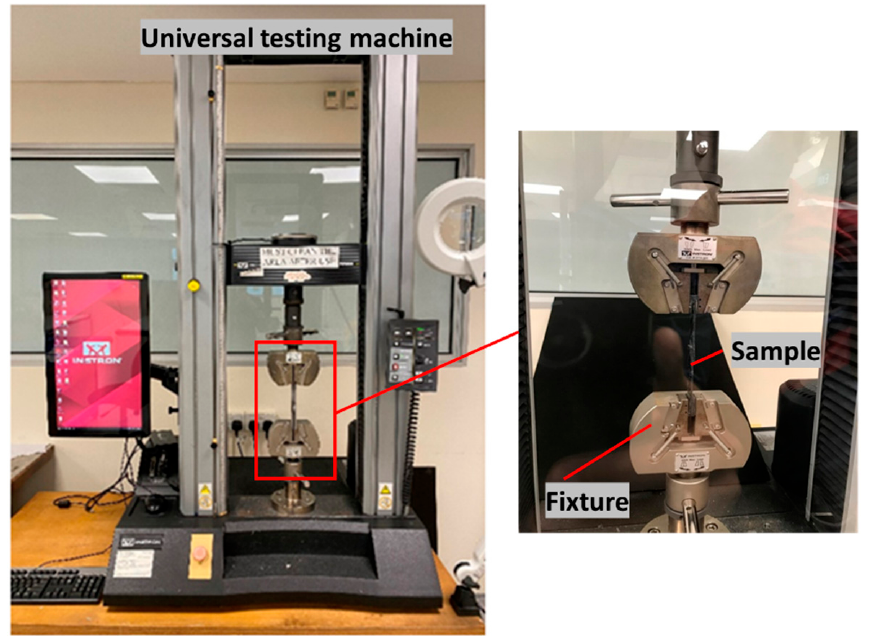
Figure 5. Universal testing machine used for static lap shear testing.